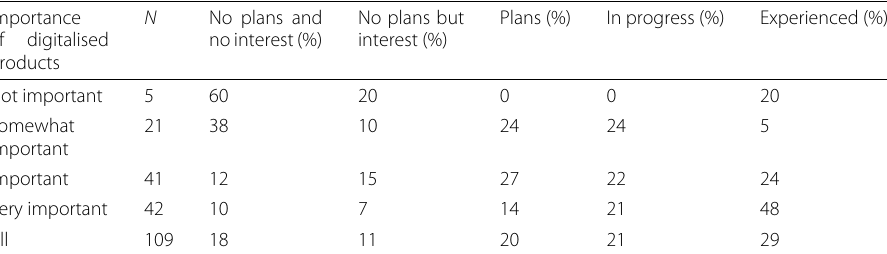
Table 7 Relationship between importance of digitalised products and level of interest and